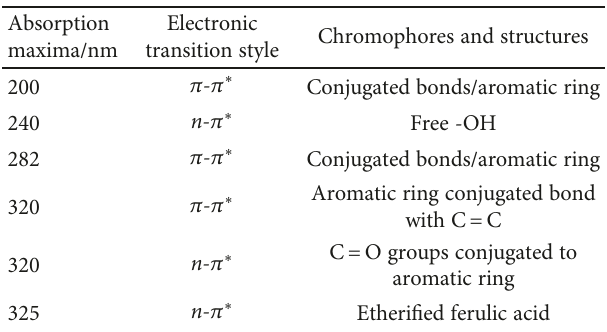
Table 1: UV spectroscopic absorptions of typical structures in lignin [25, 30, 50, 53 –